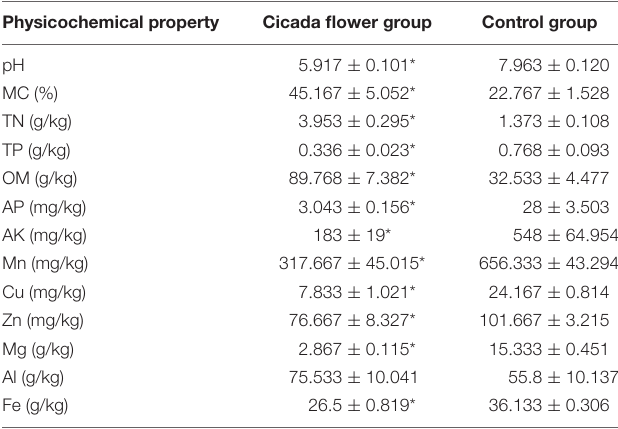
TABLE 1 | Physicochemical properties of soil